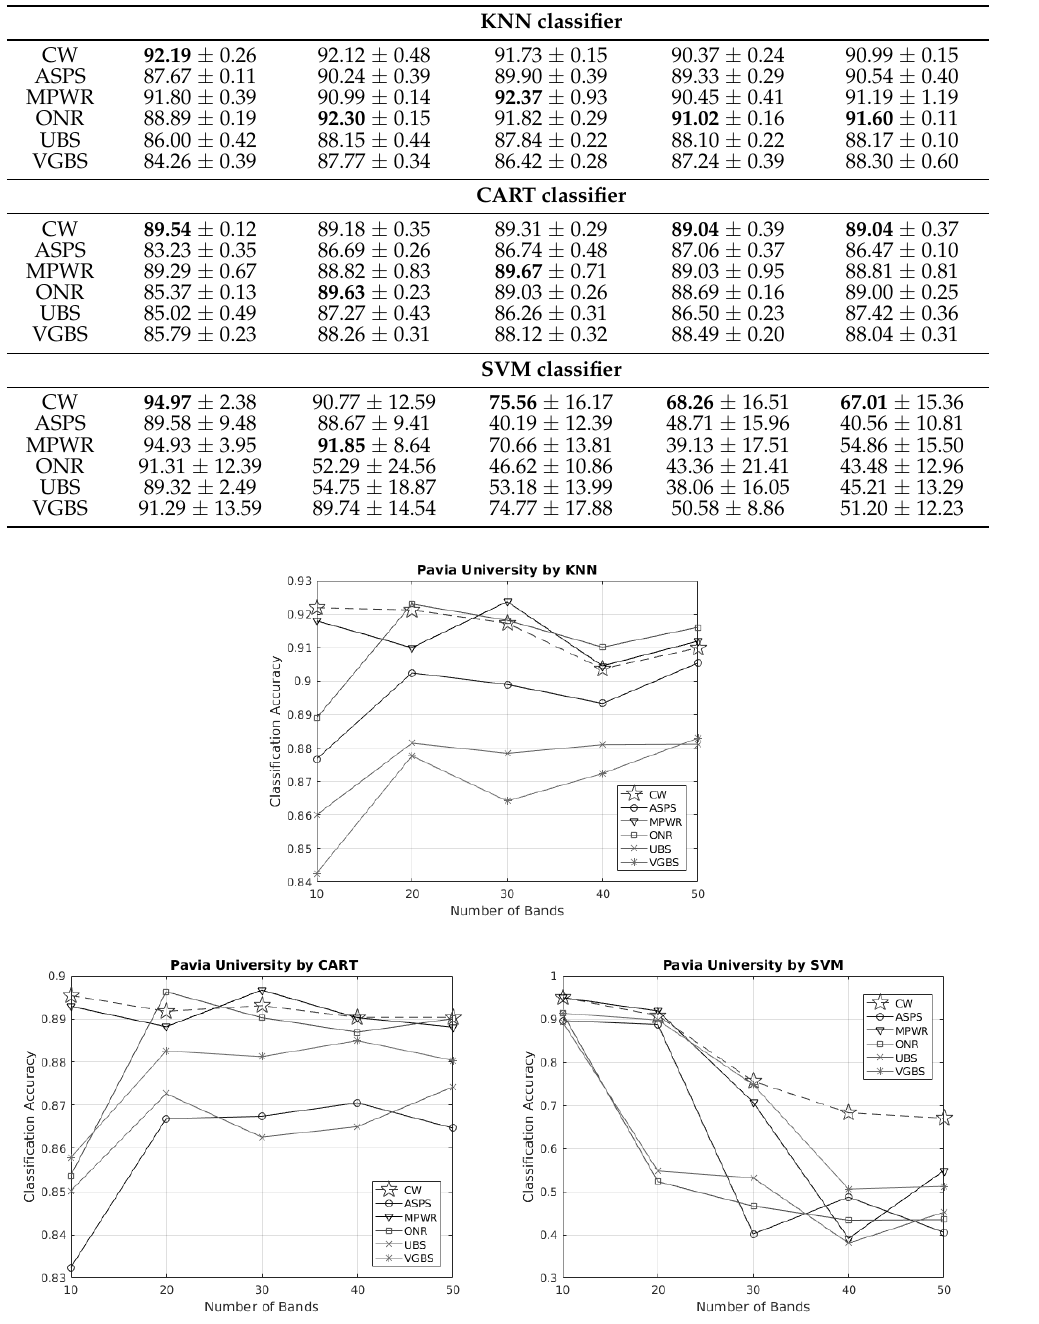
Figure 8. Overall accuracies for the Pavia University image according to KNN, CART, and SVM classifiers. Figure 9 indicates that all the one-versus-all separating hyperplanes solutions